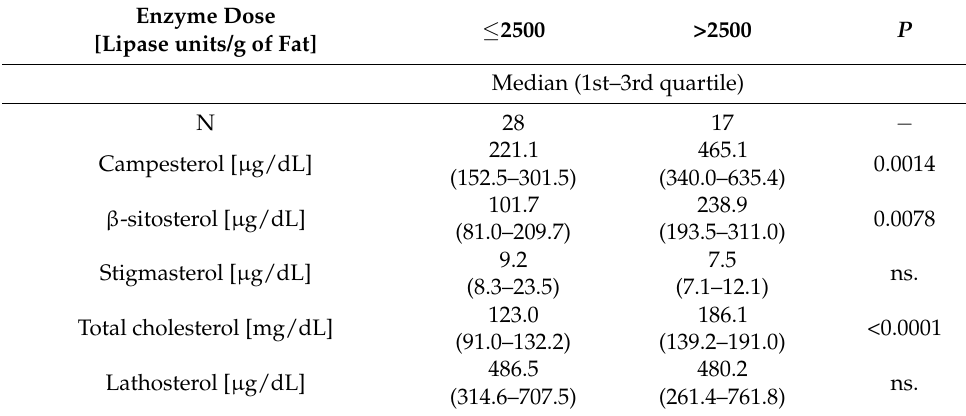
Figure 4. The relationships between enzyme intake (lipase units/g of fat) and phytosterol concentrations ( µ g/dL) in pancreatic-insufficient patients. Table 6. Sterol concentrations in subgroups of cystic fibrosis patients supplemented with higher and lower pancreatic enzyme